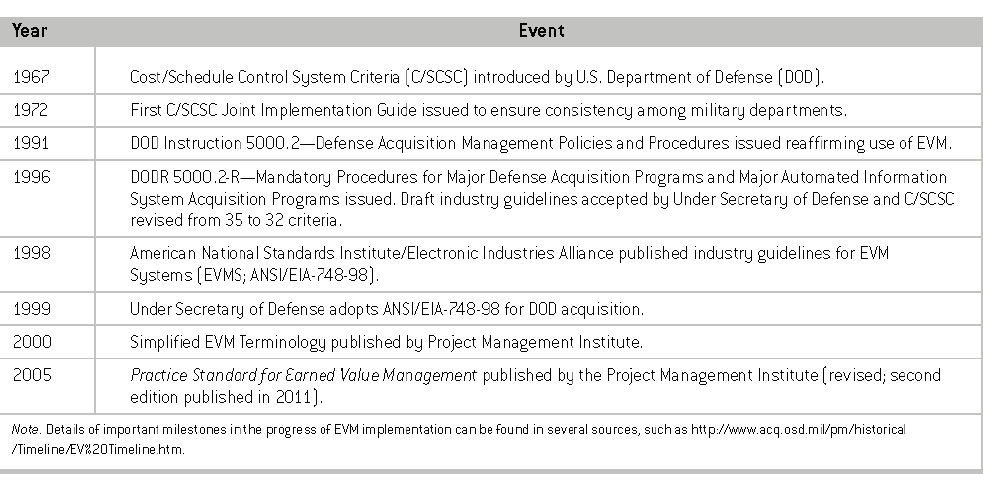
Fig. 1. EVM progress timeline (Kwak & Anbari, 2012: